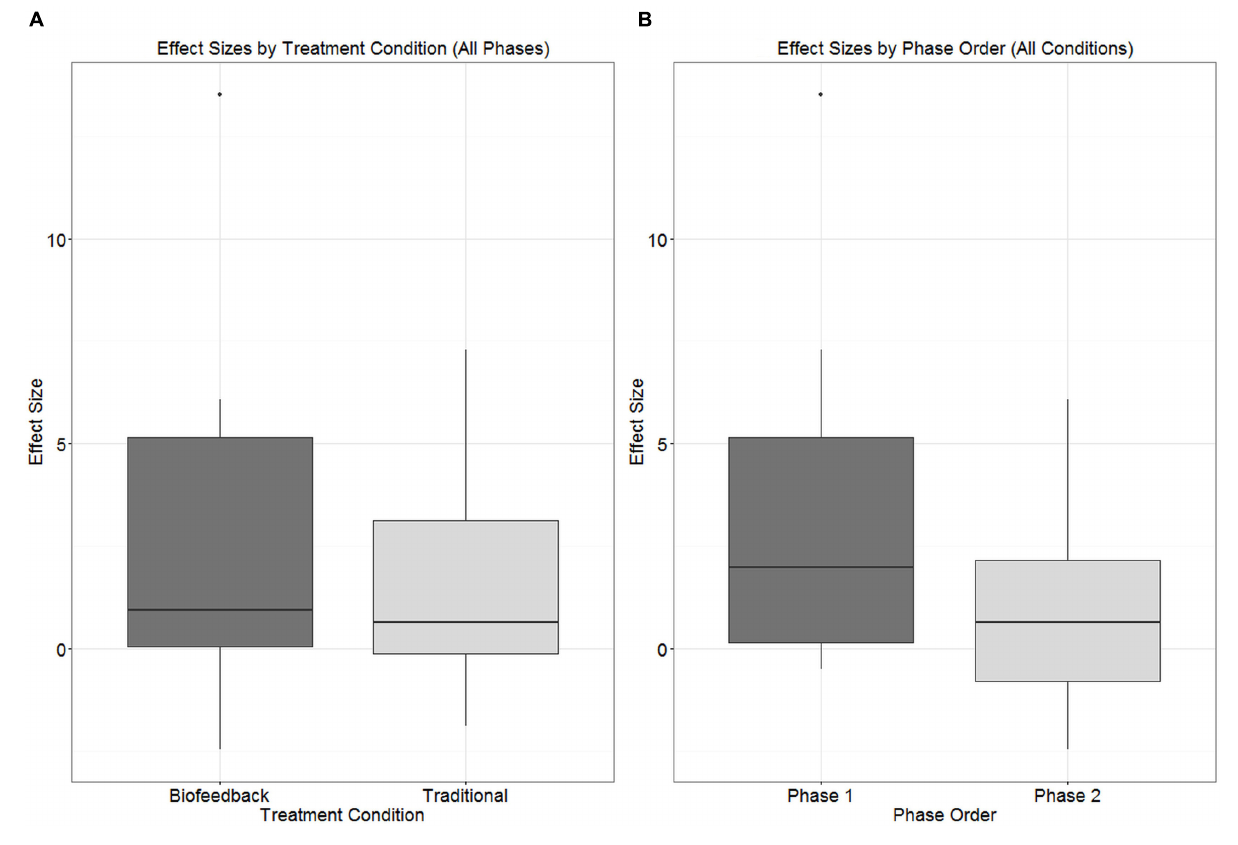
FIGURE 5 | Boxplots depicting the distribution of effect sizes observed in connection with (A) biofeedback versus traditional treatment condition, independent of phase; (B) Phase 1 versus Phase 2 of treatment, independent of treatment